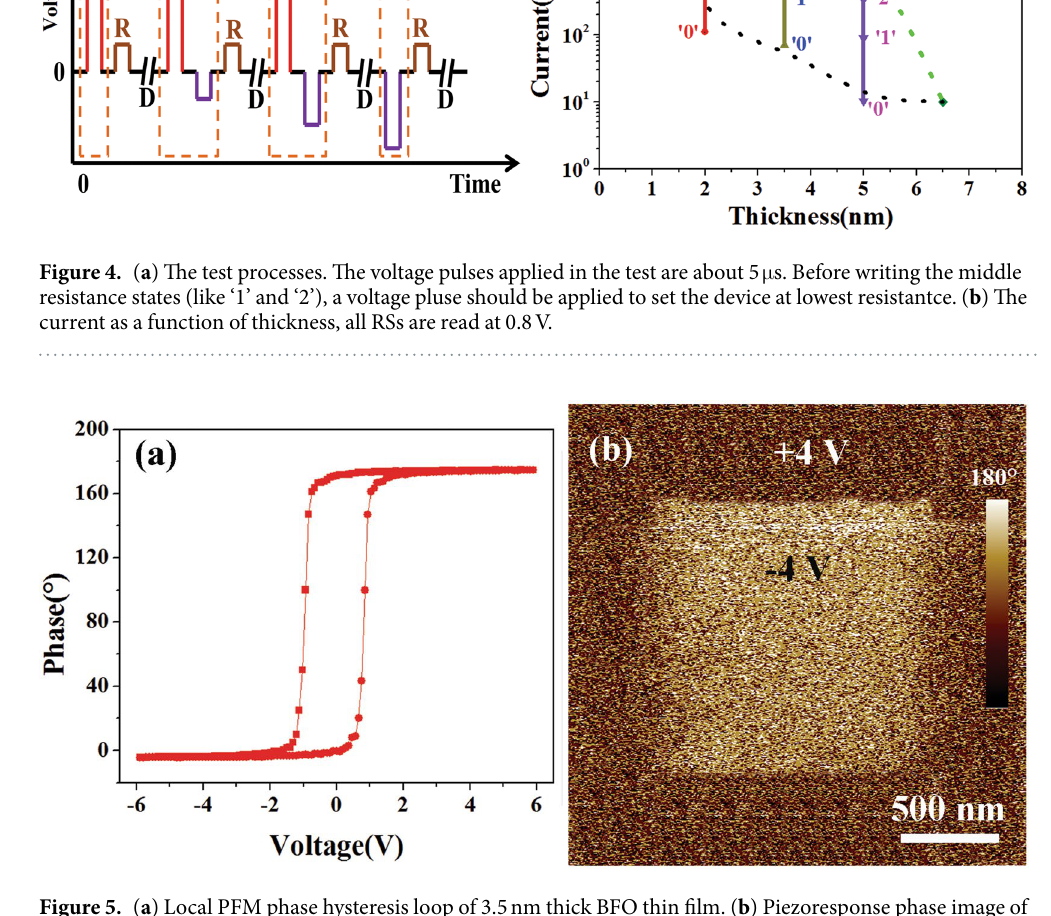
Figure 5. ( a ) Local PFM phase hysteresis loop of 3.5 nm thick BFO thin film. ( b ) Piezoresponse phase image of the 3.5 nm thick BFO